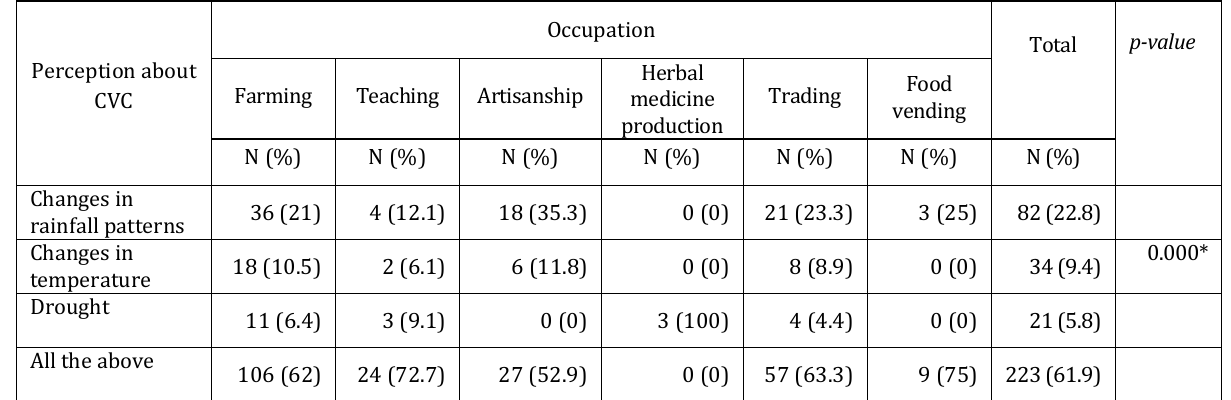
Table 3. Chi-Square test of Occupation by Perception about CVC